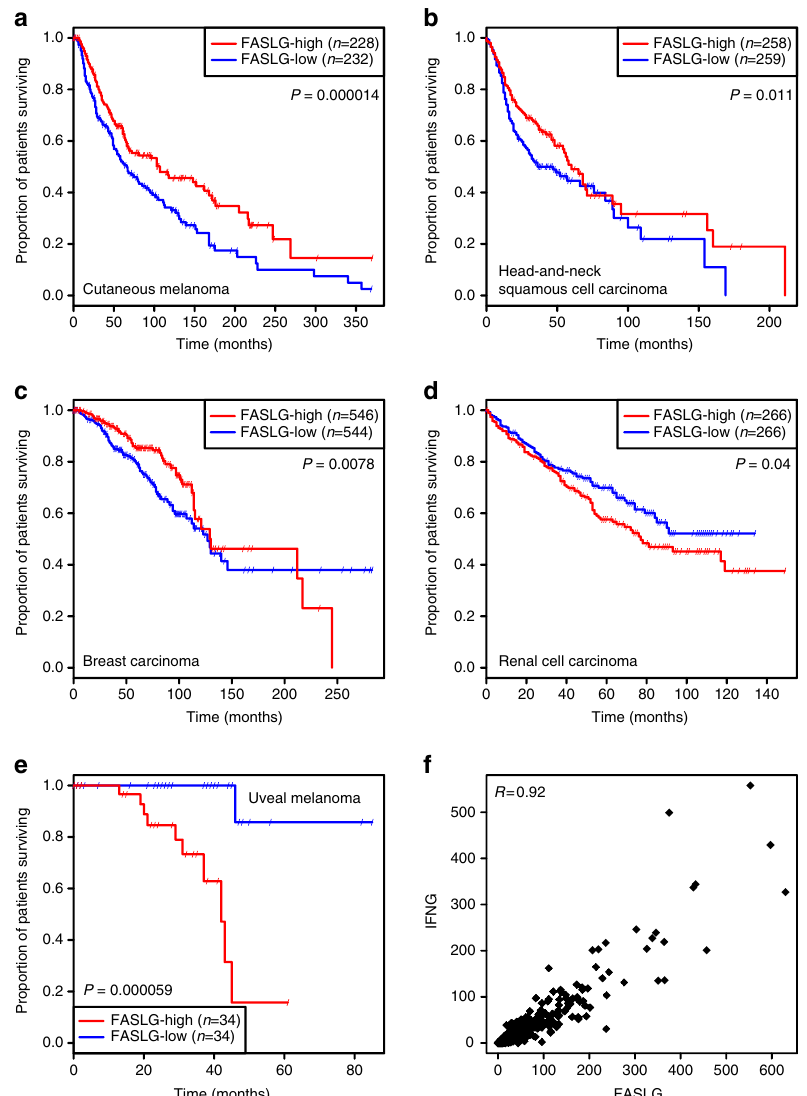
Fig. 9 Correlation between Fas-ligand expression in human tumors and patient survival. Survival curves of patients with: a cutaneous melanoma, b head- and-neck squamous cell carcinoma, c breast carcinoma, d renal cell carcinoma and e uveal melanoma, according to high ( red line ) and low ( blue line ) tumoral expression of the FASLG gene. Leaning bars indicate censored cases. The survival curves of the two groups were compared using Cox proportional hazard regression. Only the tumor types with signi fi cant survival difference are shown. f Correlation between FASLG and IFNG transcript levels in the TCGA melanoma samples ( n = 469). Each dot represents a tumor sample. X and Y values indicate RPKM-normalized transcript numbers. Pearson ’ s coef fi cient of correlation ( R ) is